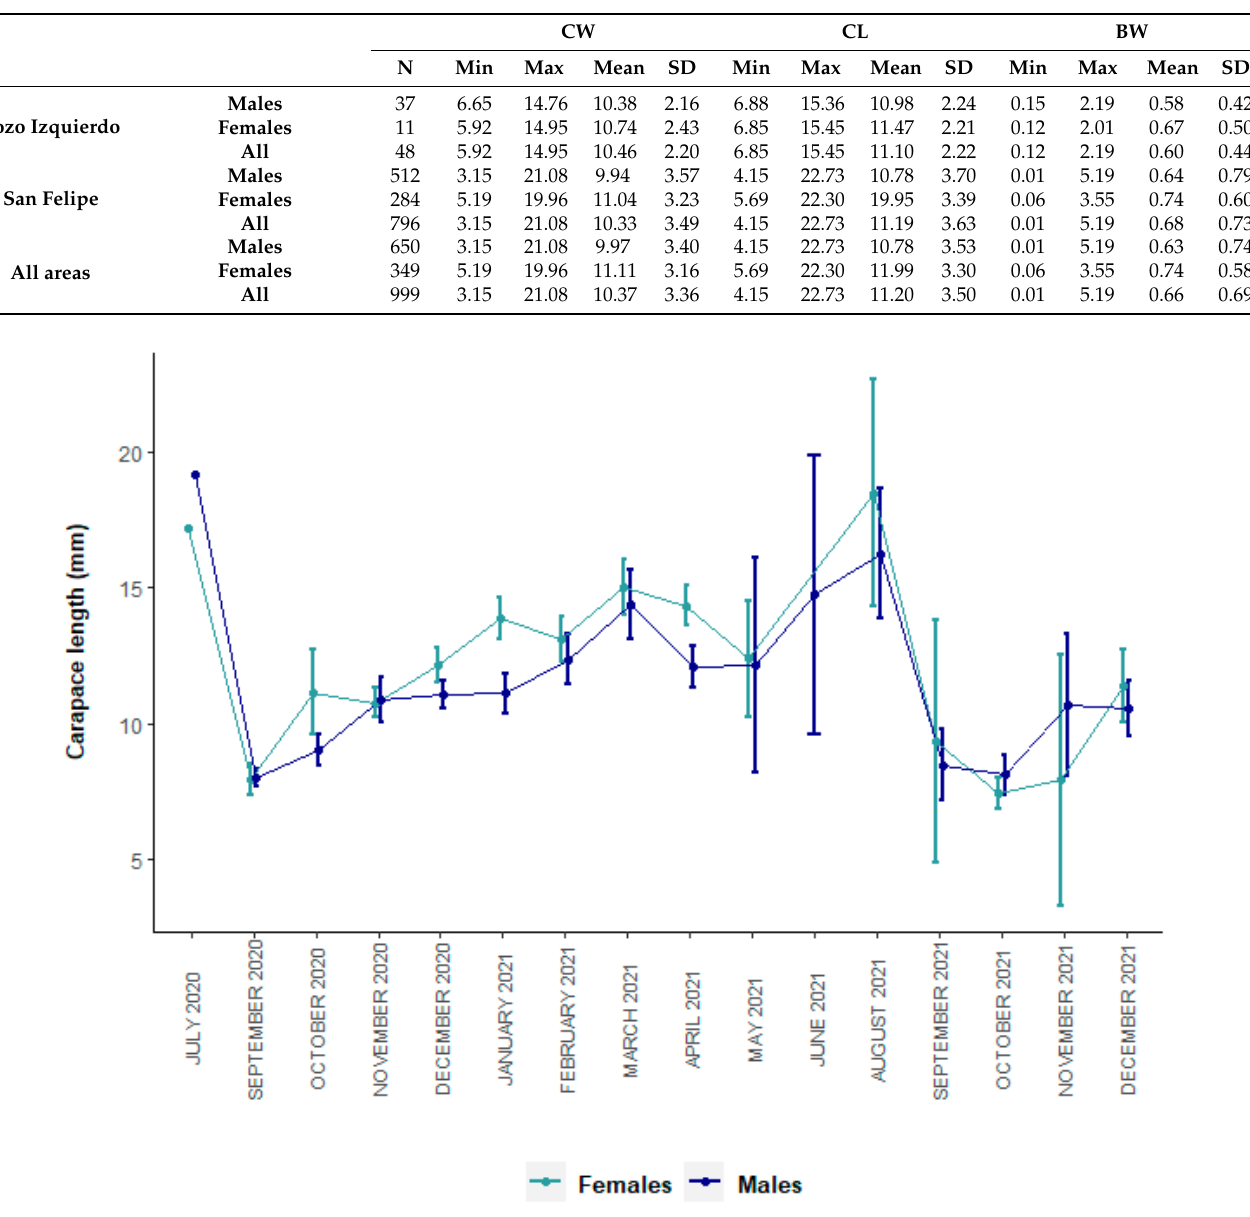
Figure 4. Monthly mean carapace length distribution, according to sex, in intertidal areas of Gran Canaria between July 2020 and December 2021.